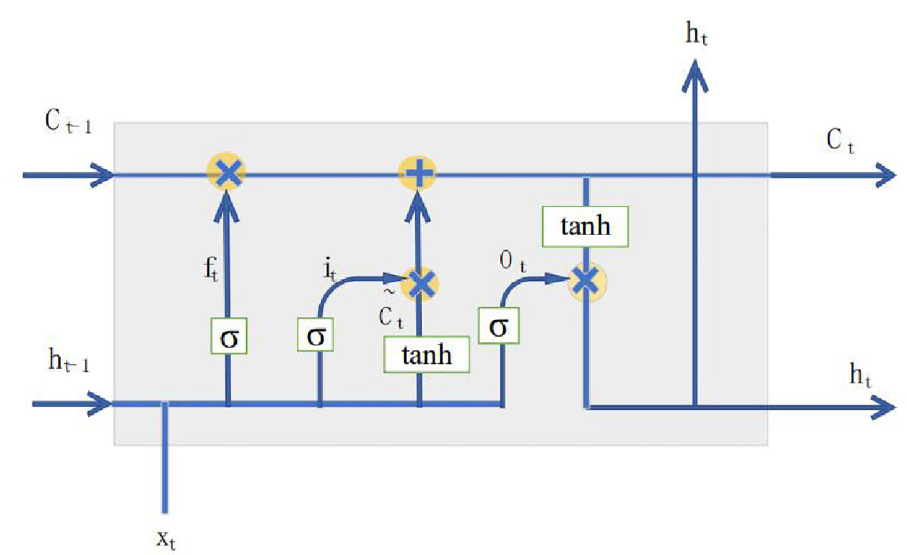
Fig 1. The repeating module in an